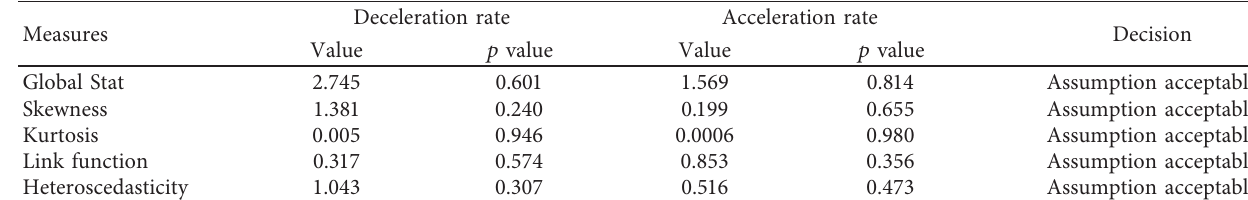
Table 11: Global validation of linear model assumptions.